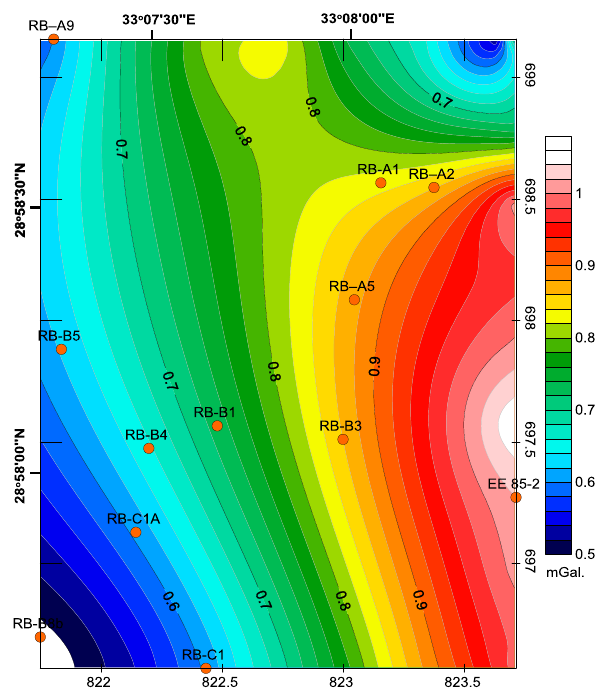
Fig. 4 Residual anomaly map of the Bouguer gravity data